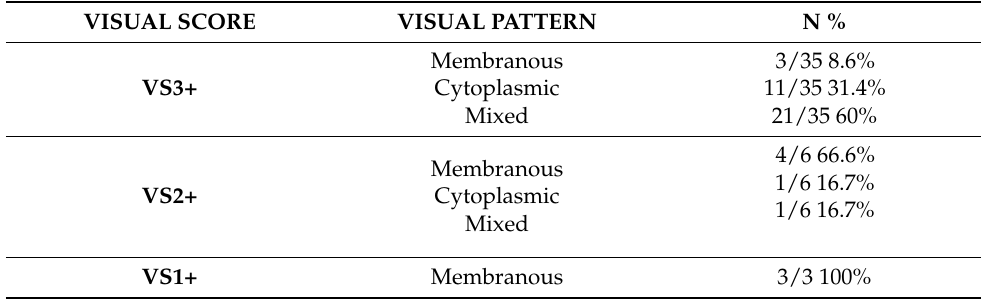
Table 4. Correlation between visual score and visual pattern.